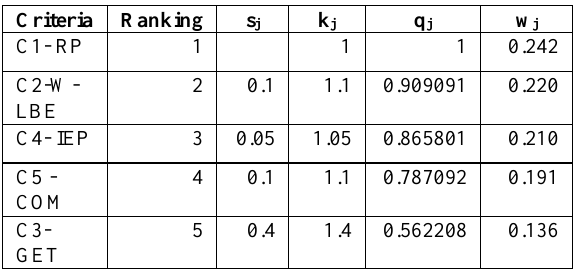
Table 4: SWARA Weighting Results for DM 2